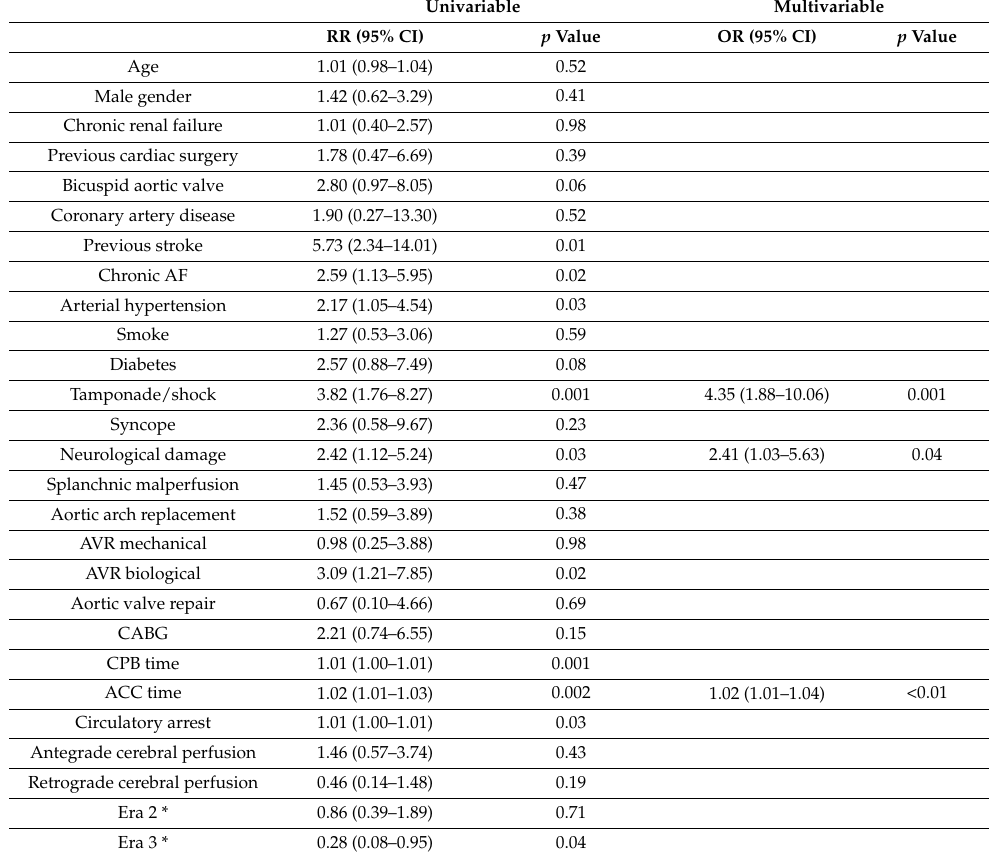
Table 4. Univariable and multivariable log-binomial regression analysis of baseline covariates in relation to 30-day